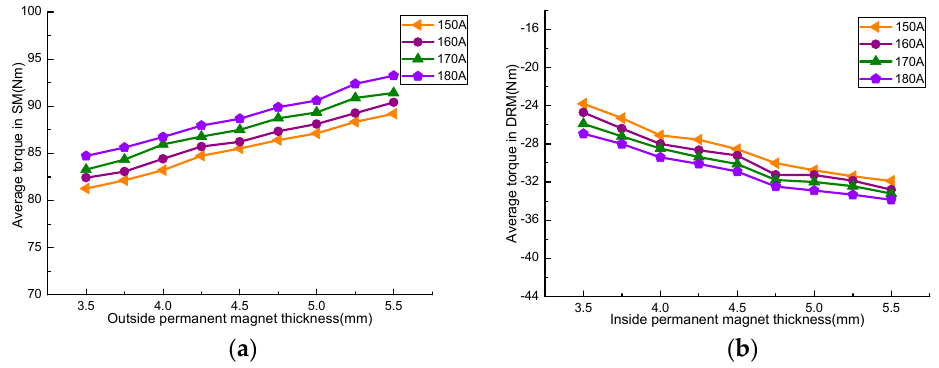
Figure 10. Relationship of average torque between SM, DRM, and permanent magnet thickness: ( a ) SM; ( b ) DRM.